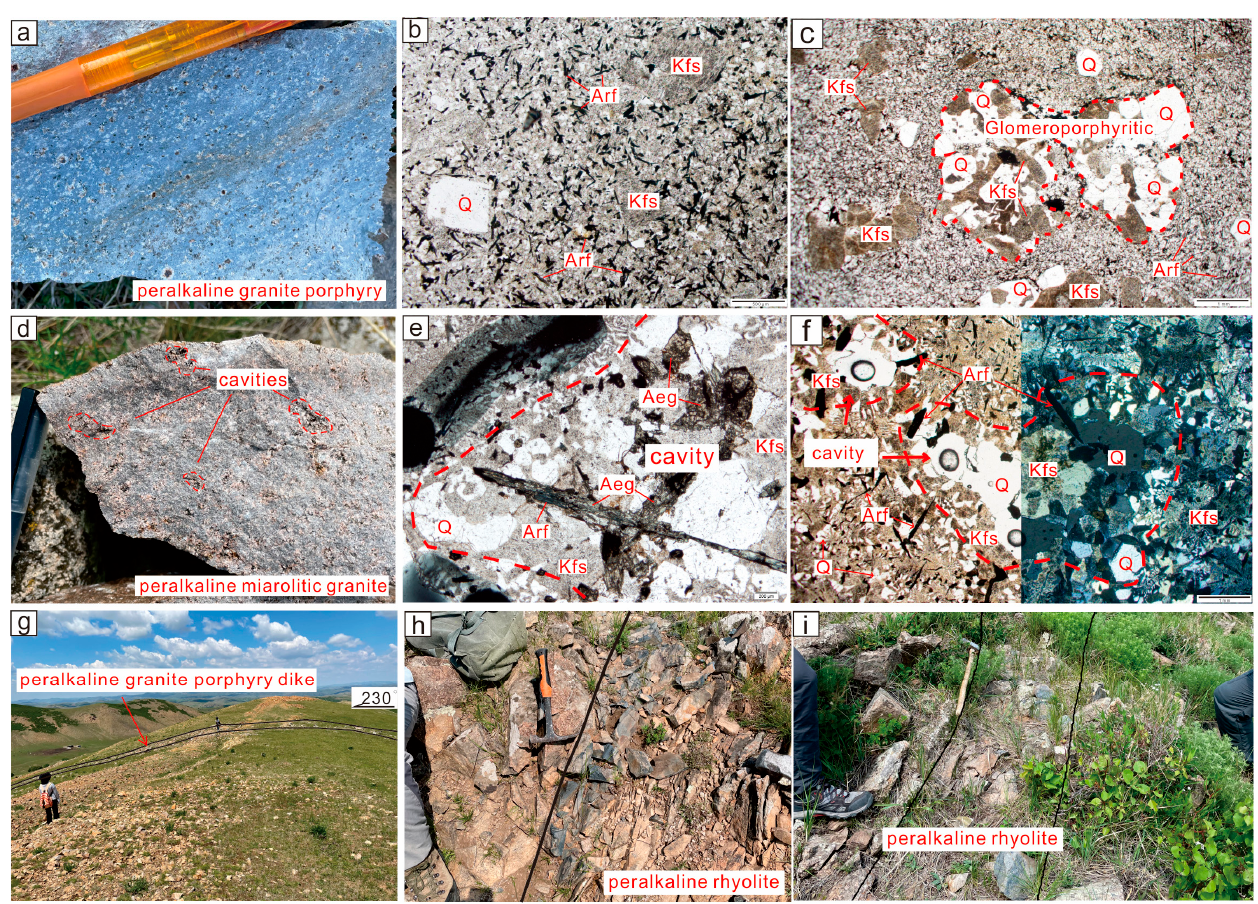
Figure 3. Photographs and photomicrographs of the peralkaline granite porphyry and peralkaline miarolitic granite dikes in the Baerzhe area. ( a ) Photograph of hand specimen of the peralkaline granite porphyry; ( b ) Photomicrograph of peralkaline granite porphyry; ( c ) Glomeroporphyritic in peralkaline granite porphyry; ( d ) Cativities in peralkaline miarolitic granite; ( e ) The arfvedsonite in cativities of peralkaline miarolitic granite were altered to aegirine; ( f ) Photomicrograph of cativities in peralkaline miarolitic granite; ( g ) The field photograph of peralkaline granite porphyry dike; and ( h , i ) Contact relationship between the peralkaline rhyolite and the surrounding rocks (The black solid line is the boundary line of the dike). Abbreviations: Q = Quartz; Arf = Arfvedsonite; Kfs = K-feldspar; Aeg = Aegirine.